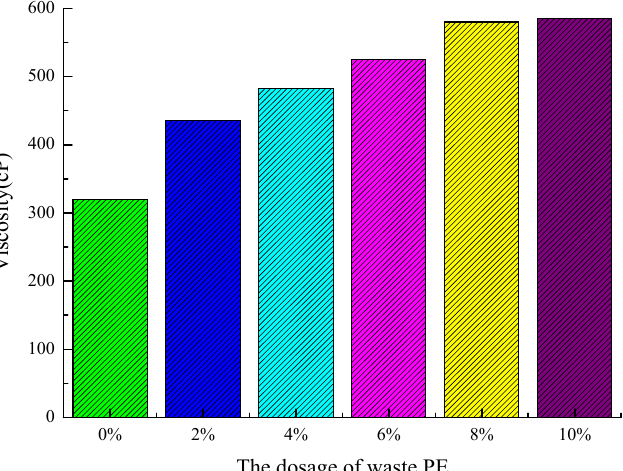
Figure 4. Viscosity of waste plastic/rubber-modified asphalt at various dosages of waste polyethylene.